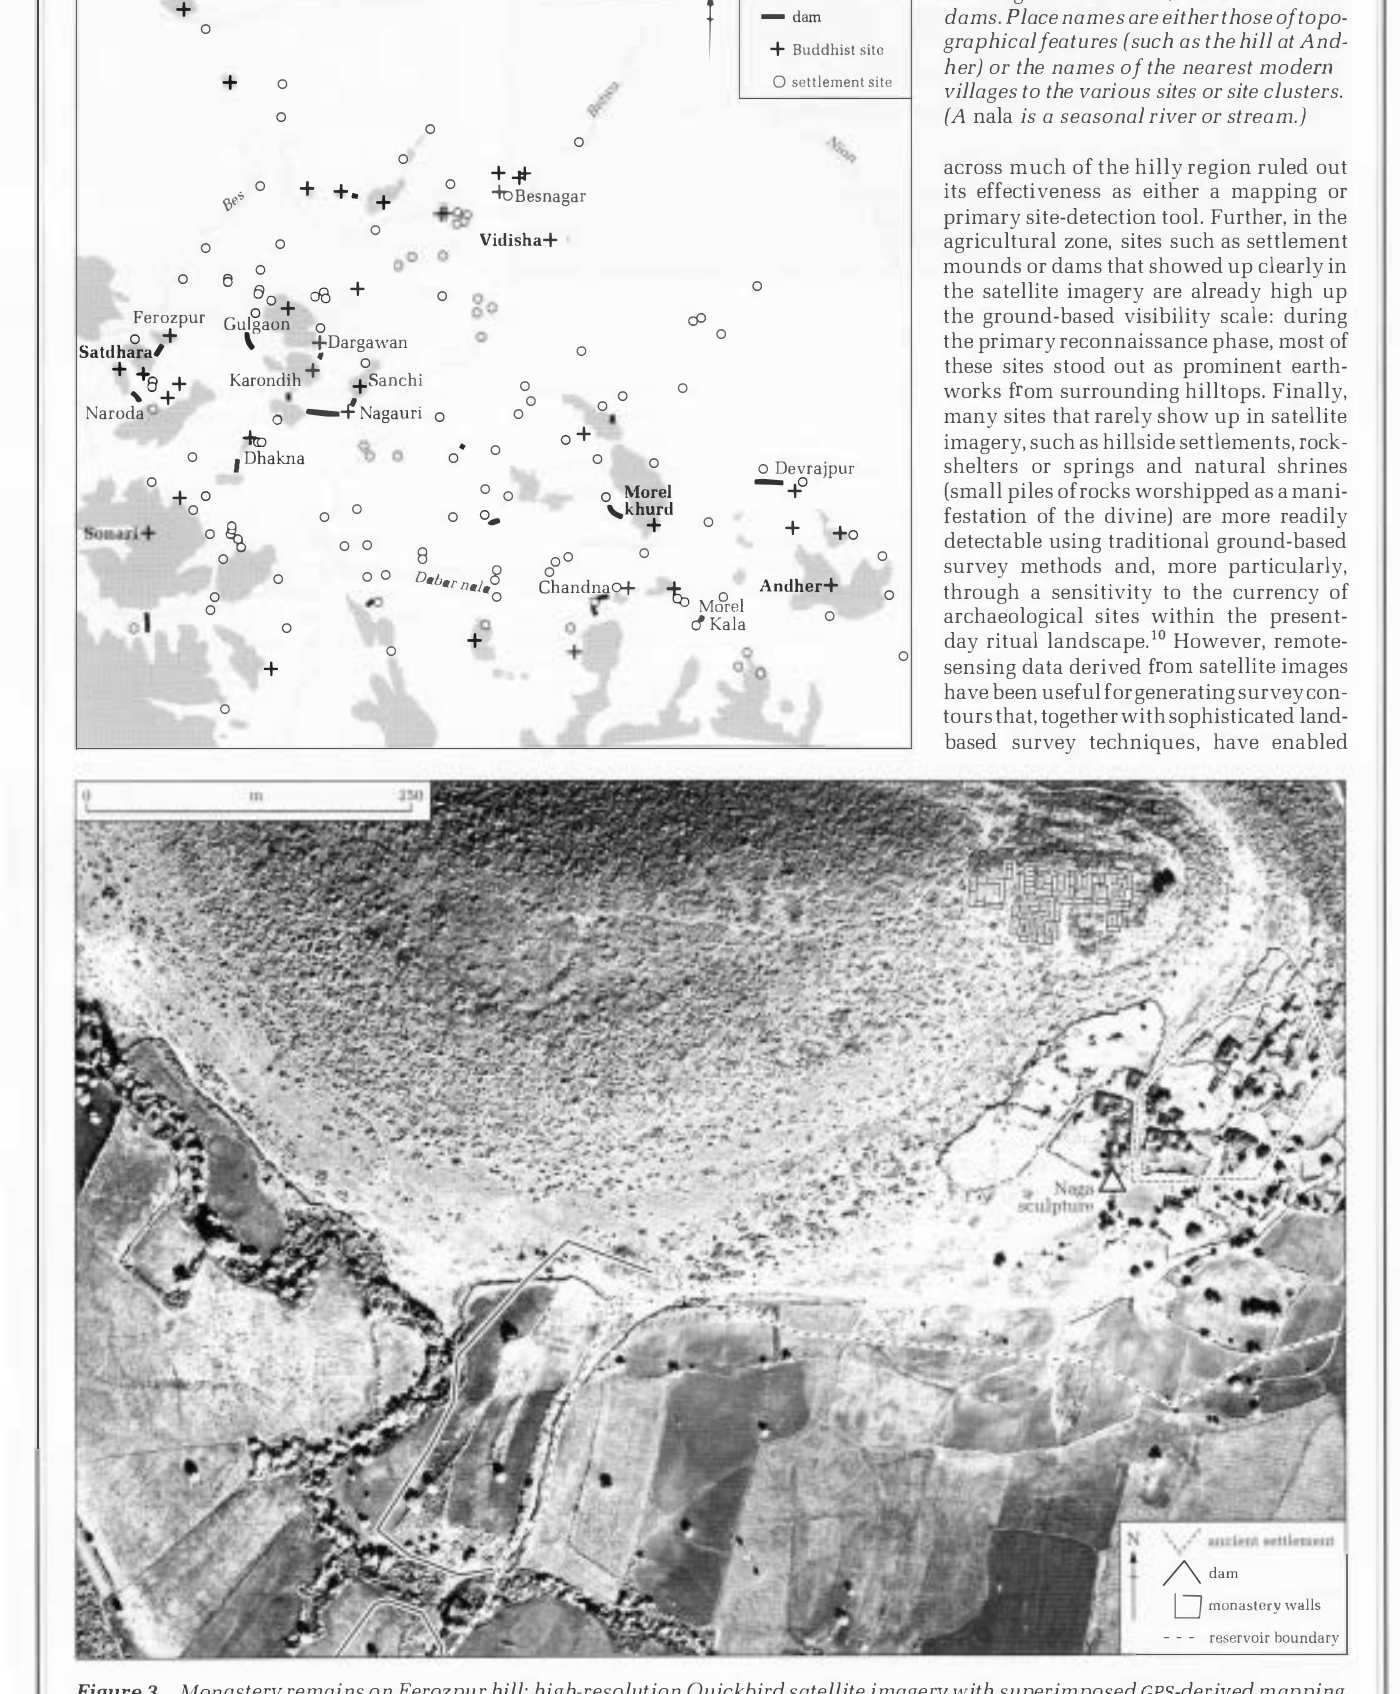
Figure 2 The Sanchi Survey study area, showing Buddhist sites, settlements and dams. Place names are either those of topo­ graphical features (such as the hill at And­ her) or the names of the nearest modern villages to the various sites or site clusters. (A nala is a seasonal river or stream.)